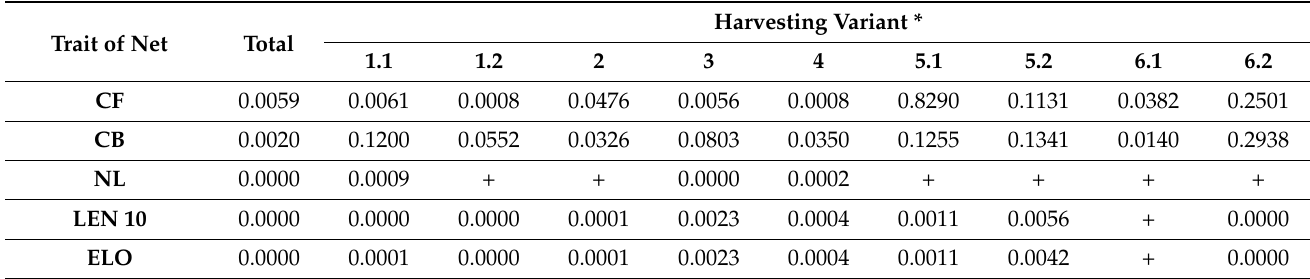
Table 2. p -values of the Shapiro–Wilk test of normality.